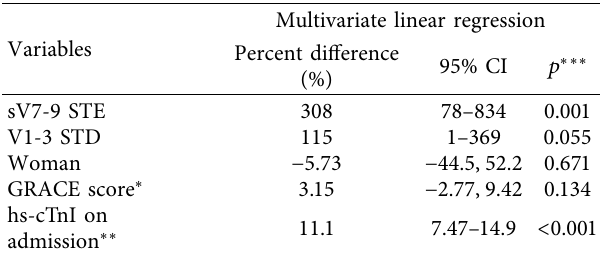
Table 4: Multivariate linear regression analysis for peak